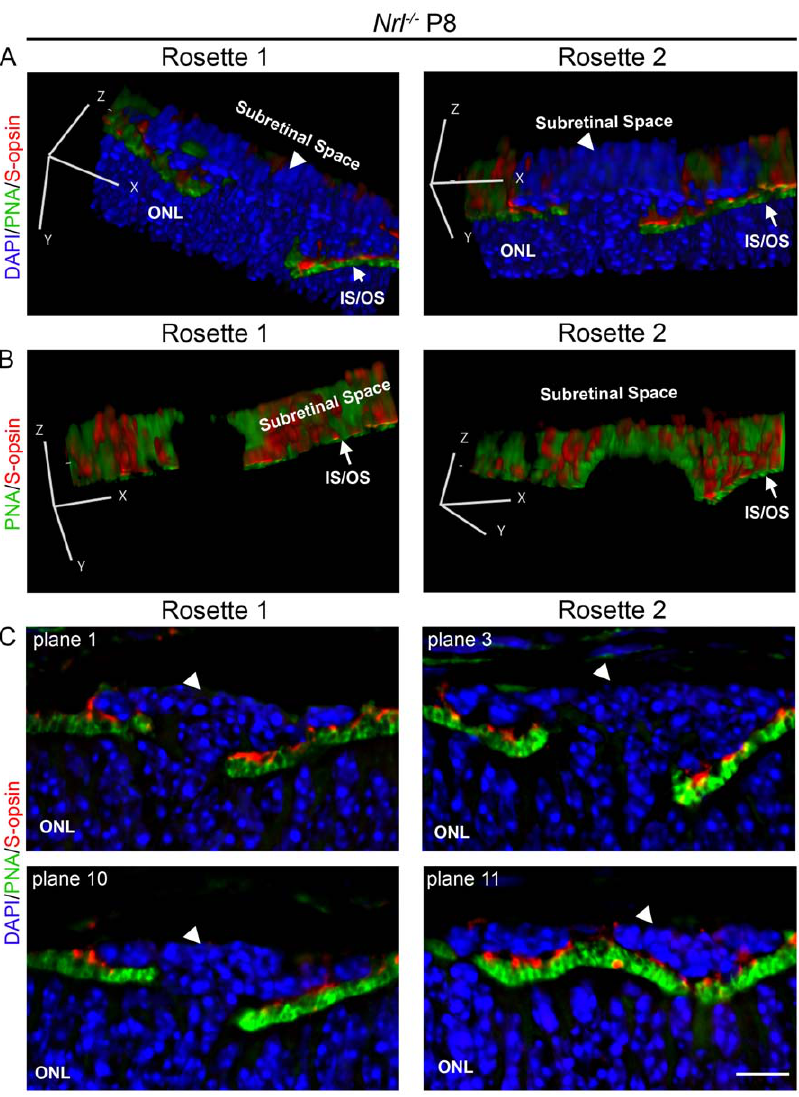
Figure 2. Three dimensional reconstruction of a P8 nascent rosette. Cone OSs were stained using S-opsin antibody (red) and cone extra cellular matrix was labeled with PNA (green) while nuclei were counterstained with DAPI (blue). Three dimensional reconstructions were created using ImageJ. A . Representative 3D reconstructions of two different nascent rosettes (arrowheads). B . The same two rosettes as in A are viewed with DAPI turned off and the viewing angle changed (refer to axes) to visualize the gaps through which the aberrant cells protrude. C . Selected single planes from the same two rosettes as A–B . ONL: outer nuclear layer, IS/OS: inner segments/outer segments Scale bar, 20 m m.